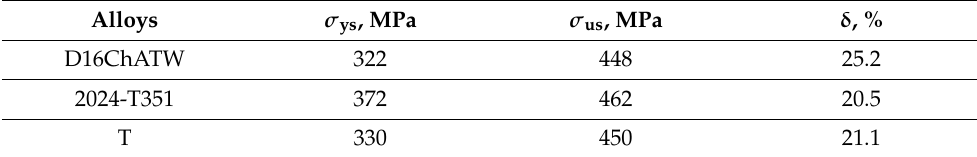
Table 2. Mechanical properties of aluminum alloys D16ChATW.